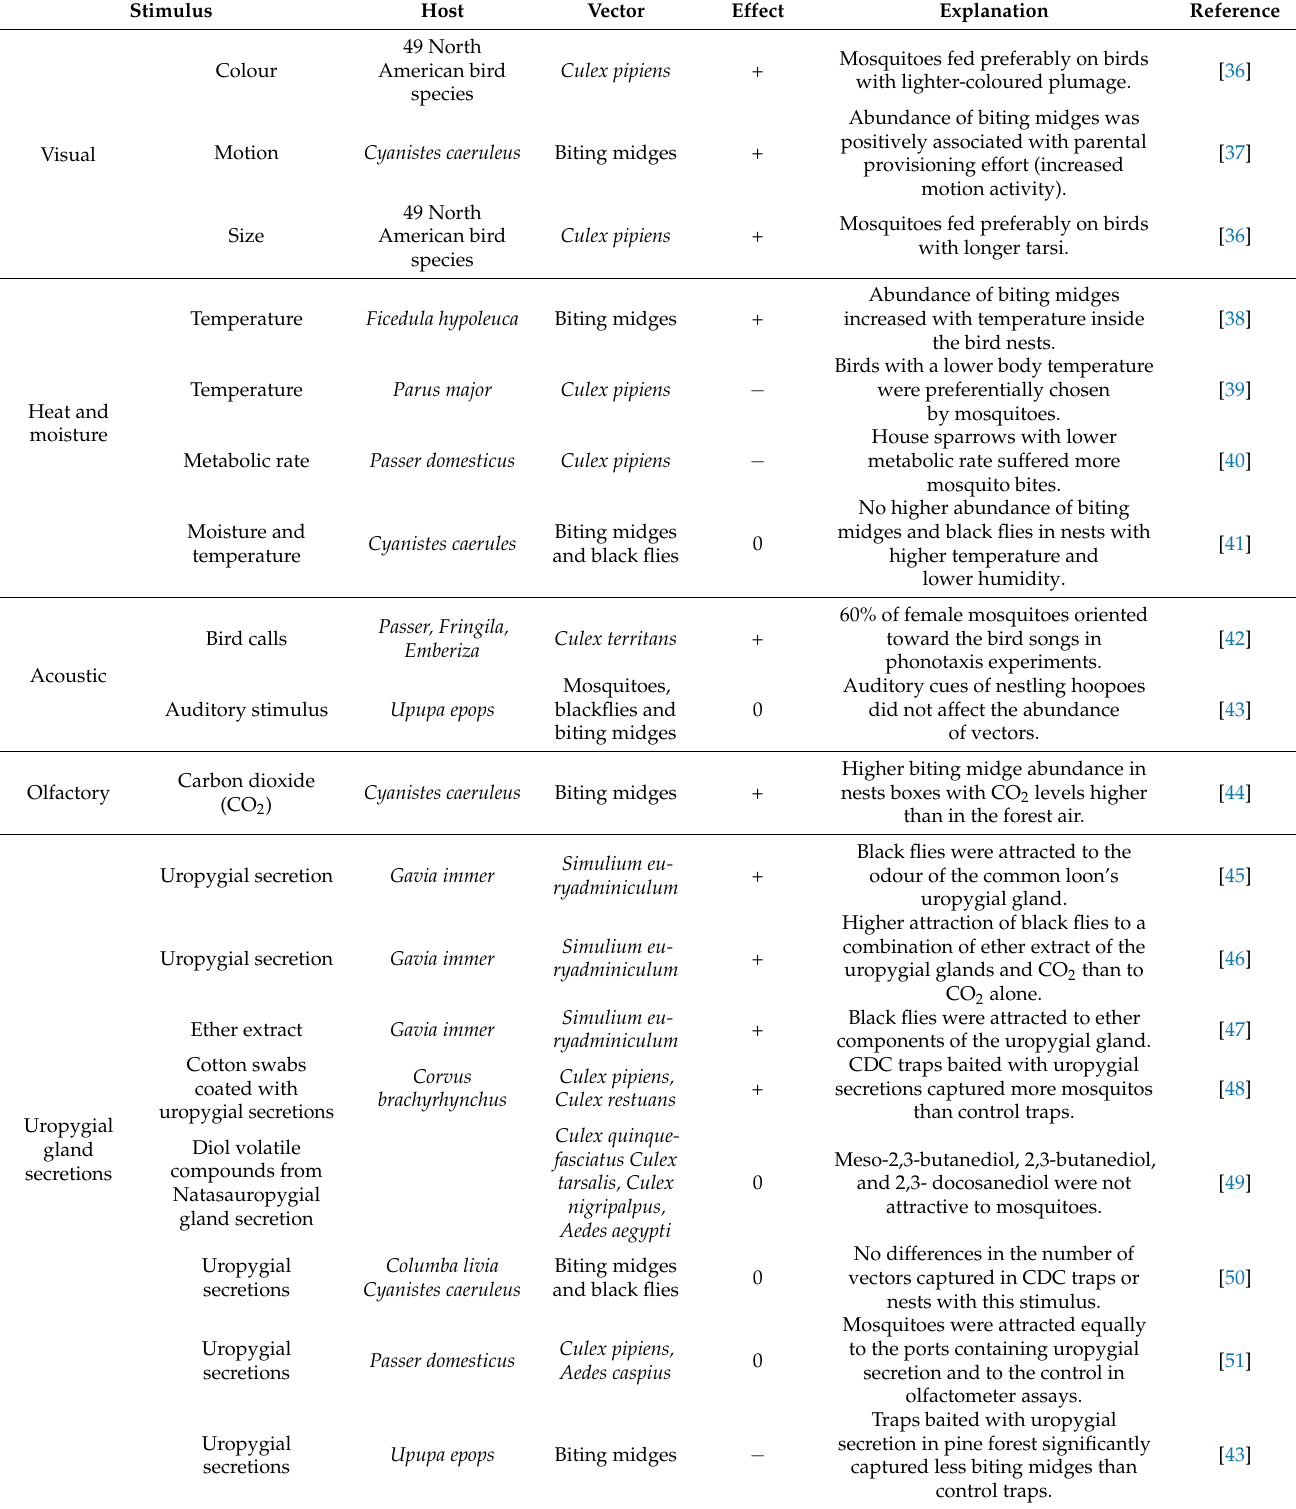
Table 1. Summary of studies reporting increased (+), decreased ( − ), or neutral (0) attraction of avian haemosporidian vectors towards different